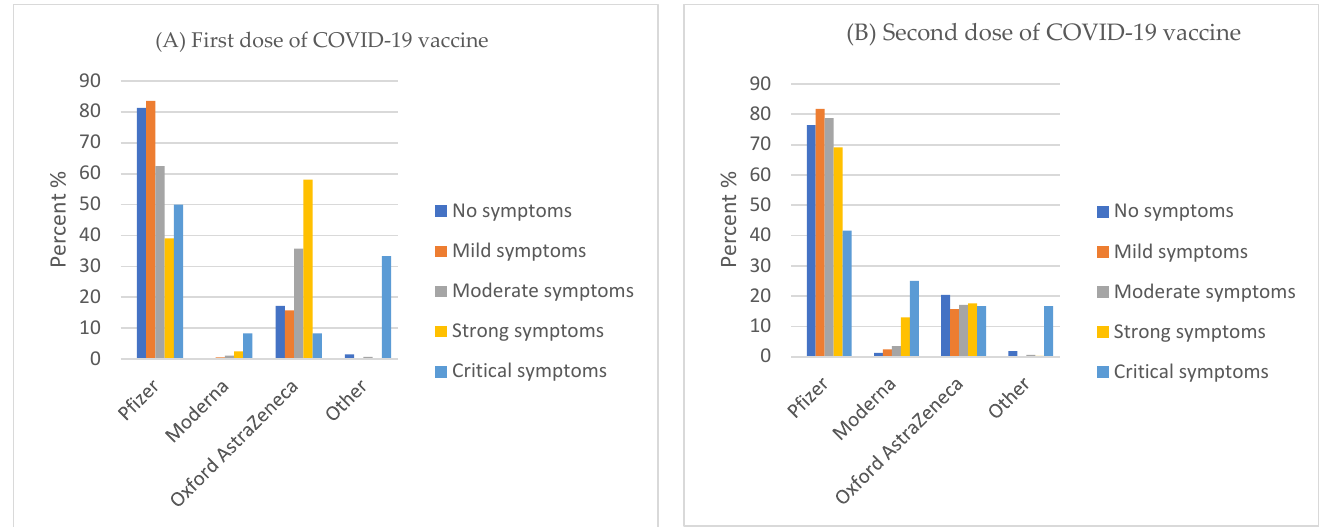
Figure 1. First dose ( A ) and second dose ( B ) of COVID-19 vaccines and their side effect symptom severity.